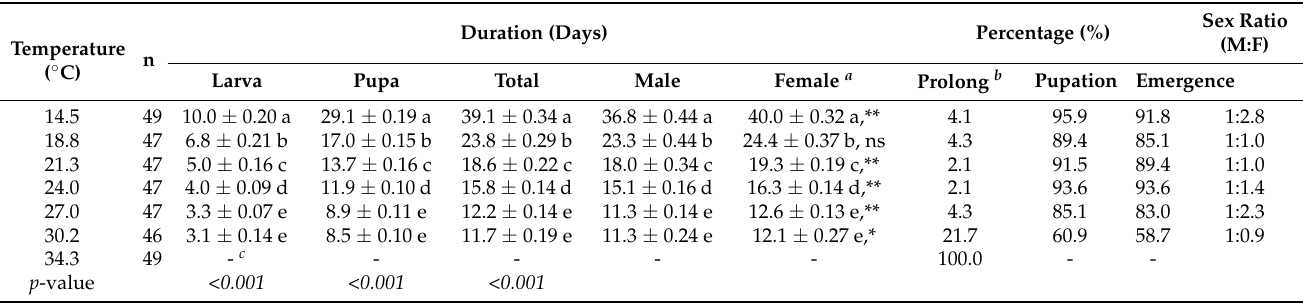
Table 2. Mean ( ± SE) developmental duration of the post-diapause periods of Eurytoma maslovskii until adult emergence at various